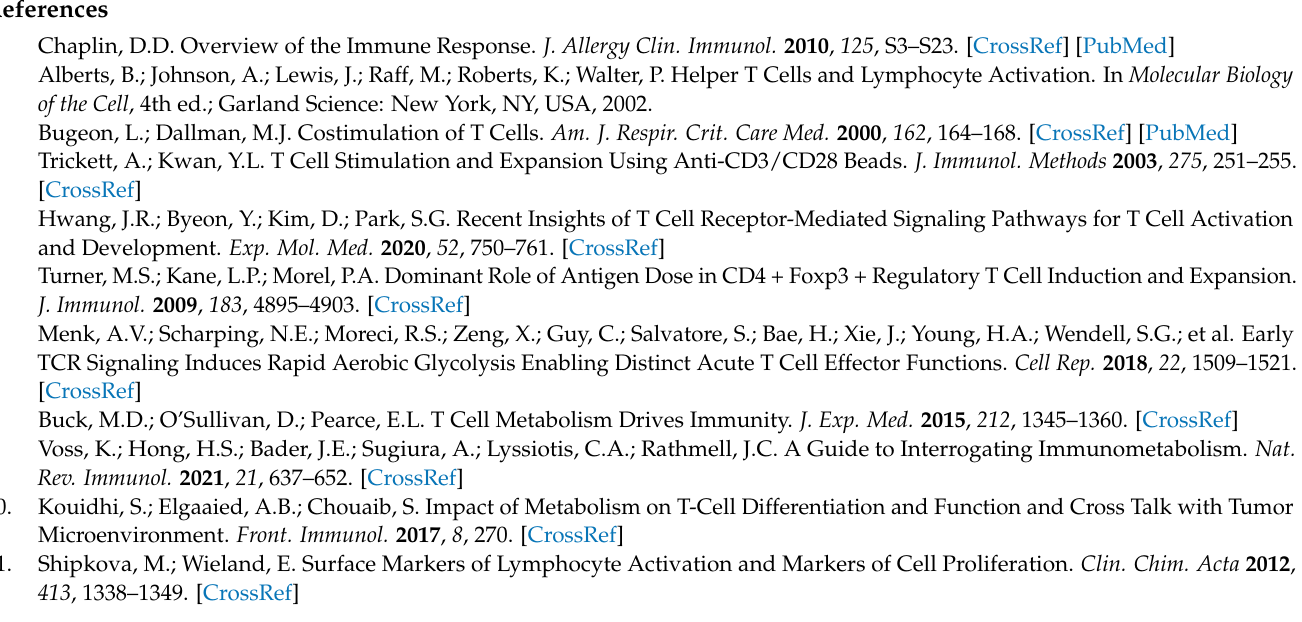
Sorting rail dimensions and position.; Figure S3: Flow cytometry analysis for CD69 expression; Figure S4: Droplet pH for ImmunoCult Activation; Figure S5: Droplet pH for 2-deoxy-D-glucose (2DG) treatment; Figure S6: Logistic Regression Fits; Table S1: Typical flow parameters; Video S1: SIFT cell